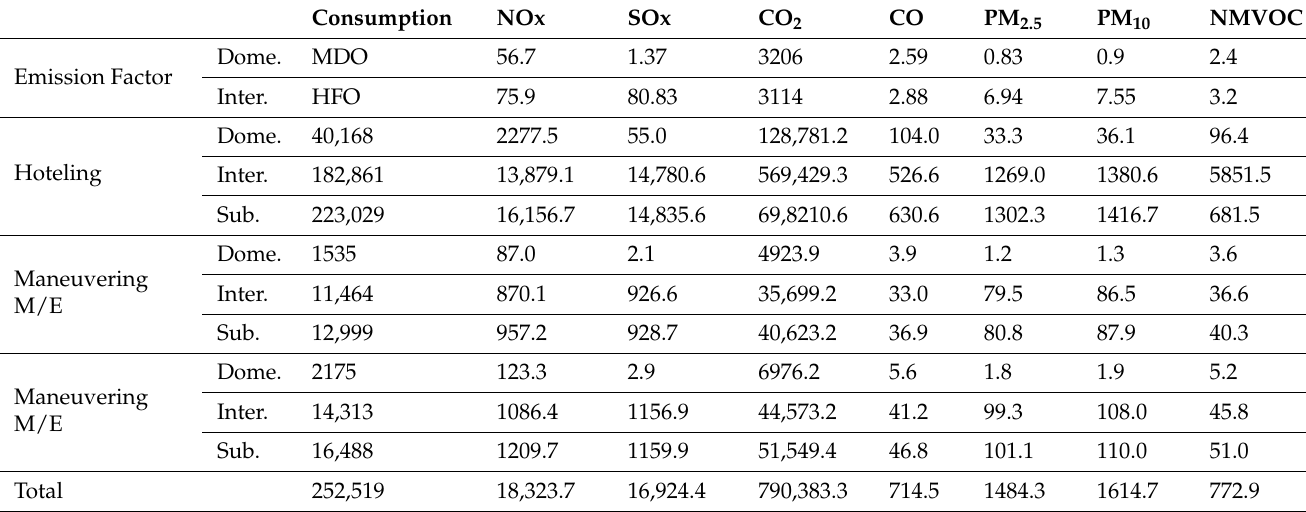
Table 7. Results of emission calculation (Unit: